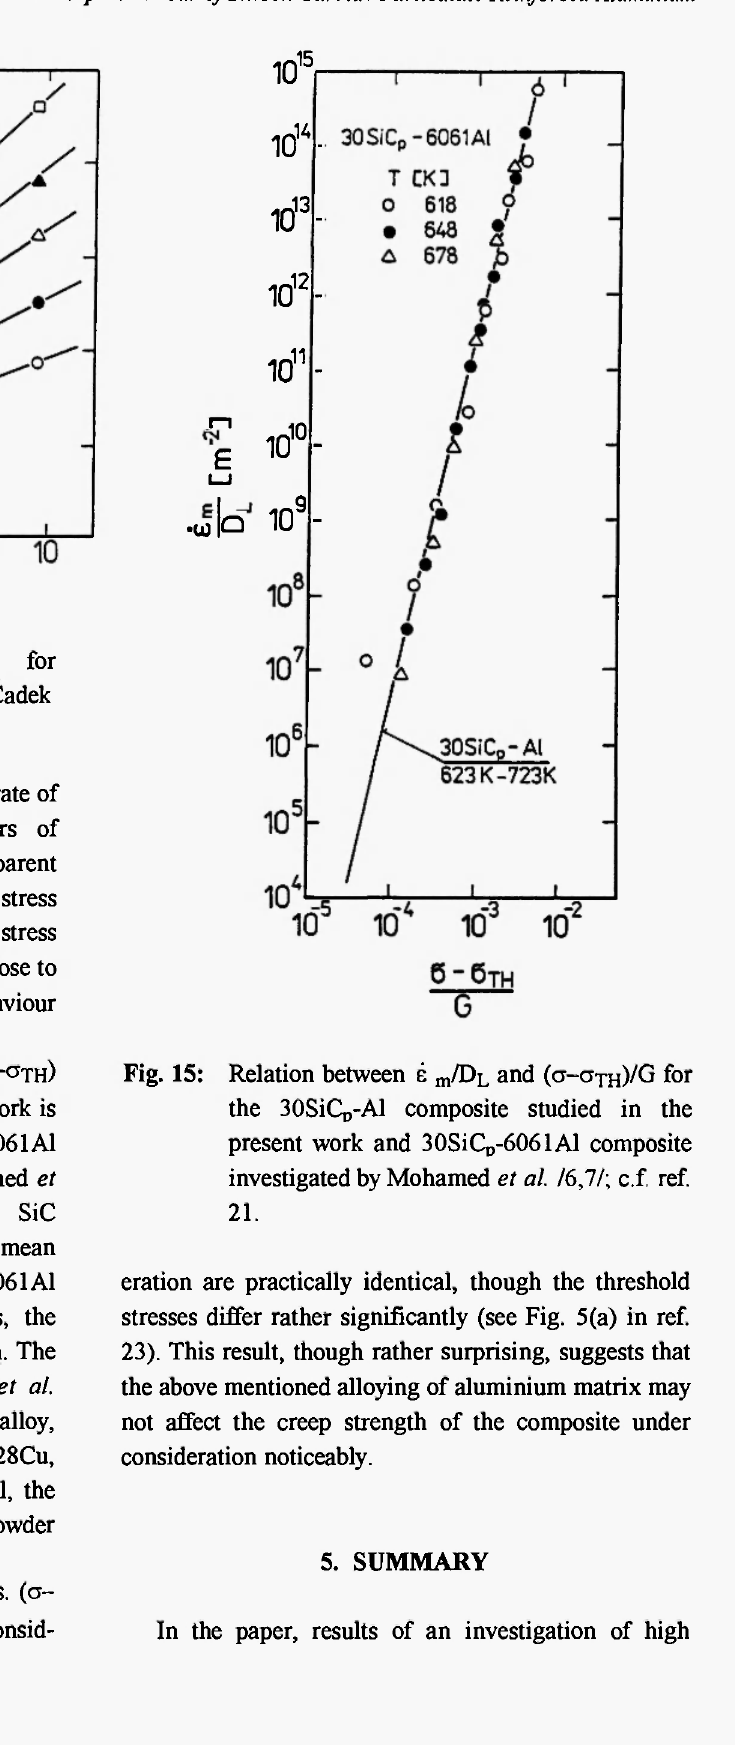
Fig. 14: Relations between έ m1/5 and σ for aluminium; data of Tobolovä and Cadek ΙΠ I.